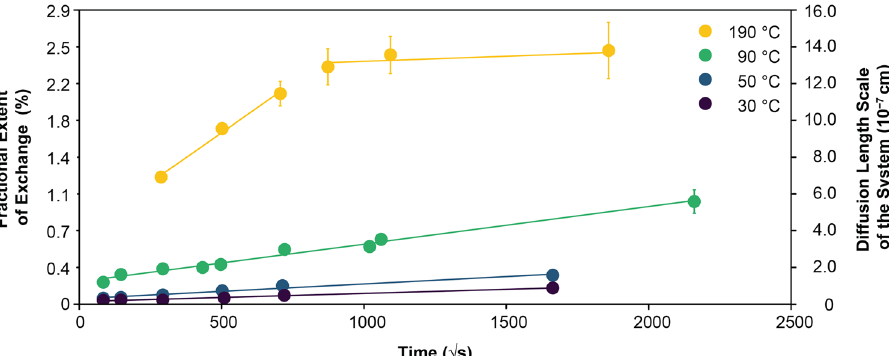
Fig. 2 The fraction ( F ) of foraminifera test calcite isotopically equilibrated with arti fi cial seawater enriched in 18 O to 1000 ‰ VSMOW plotted against the square root of time for experimental temperatures between 30 and 190 °C. Values on the left axis measure the fractional change in the bulk oxygen isotope ratio of the foraminifera tests as they evolve toward the equilibrium isotope value of the system. The right axis shows the diffusive length scales of the system ( L ), which are calculated by normalizing the product of the number of moles of oxygen exchange and the molar volume, to the aliquot-speci fi c surface area. The diffusion constant for each temperature can be obtained by squaring the slope of the L regression line. Note the change in the kinetic regime at 190 °C at an F value of 2.4% and L of 1.3 × 10 − 6 cm after 8 days. Error bars are typically smaller than the symbol size, but when visible, they correspond to one standard deviation of the variability of the isotopic measurements of the isotope exchange (Supplementary Table 1 and Fig. 2). For all with different fl uid:foraminifera test weight ratios showed the experiments, the oxygen isotope exchange rates correlated posi- same amount of isotope exchange for the same experimental tively with temperature and, within individual incubations, gra- times (Supplementary Table 1). dually decreased with time, producing a linear relationship between the amount of exchange and the square root of incu- bation time. After 54 days at 90 °C, over 1% of all the oxygen in a foraminifera test was exchanged with the surrounding pore fl uid without any discernable textural modi fi cation. Of note, exchange rates were only slightly lower for oxidatively cleaned foraminifera compared to non-oxidatively cleaned foraminifera, and aliquots isotopic exchange was not noted.